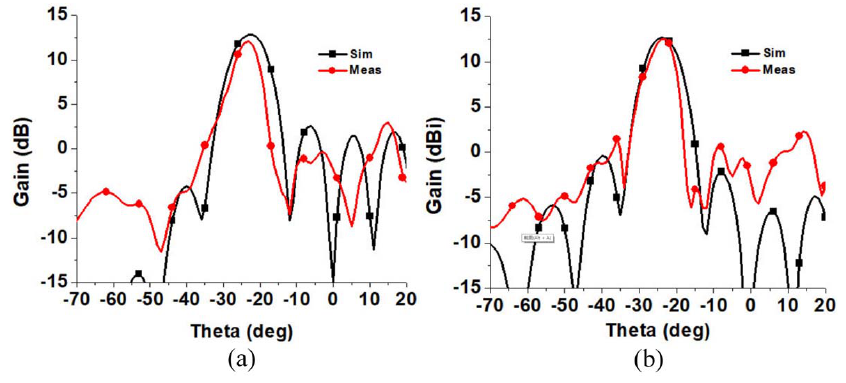
Figure 20. ( a ) The measured and simulated gains in the x–z plane when RHCP is generated; ( b ) the measured and simulated gains in the x–z plane when LHCP is